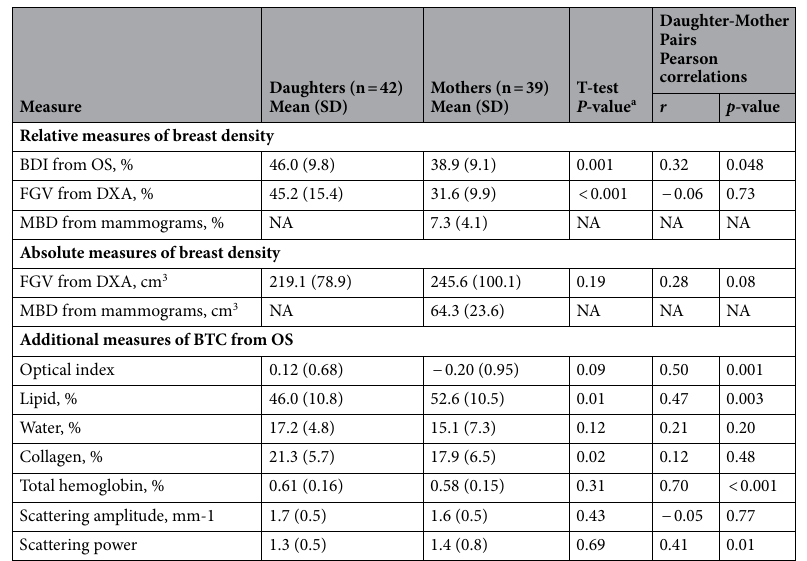
Table 1. Comparison of breast tissue measures in daughters and mothers from the Growth and Obesity Cohort Study in Santiago, Chile. BDI breast density index, BTC breast tissue composition, DXA dual-energy X-ray absorptiometry, FGV fibroglandular volume, MBD mammographic breast density, NA not available, OS optical spectroscopy. a p -value estimated from a two-sample t-test comparing sample means between daughters